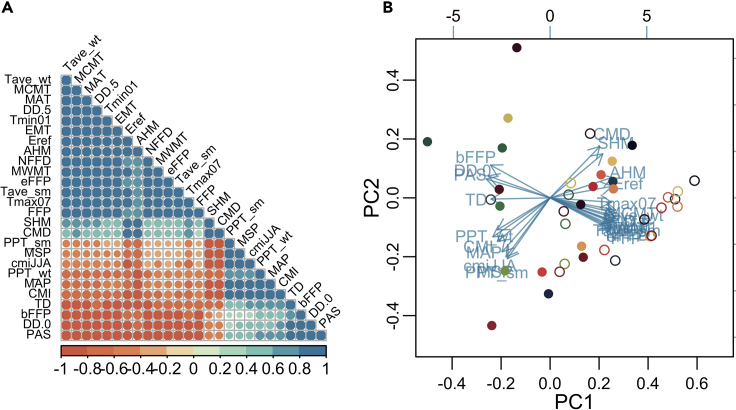
Visualizing Current and Future Climate in Principle Components SpaceA visualization of (A) climate variable correlations and (B) climate principal components space. The (A) correlations plot shows positive (blue) and negative (red) correlations between climate variables, with circle size and depth of color indicating the strength of the correlation. The (B) PCA plot depicts climate variables (blue arrows) in the first two axes of pc space. Where populations fall in PC space are shown with the colored dots, with the closed dots representing the past 30-years of climate data and their open counterparts representing where populations are expected to fall in the PC space in 2080.